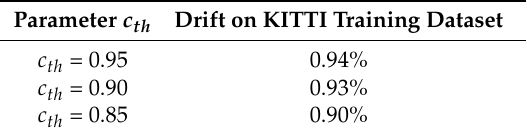
Table 3. The Influence of c th for Ground Features to the Result.